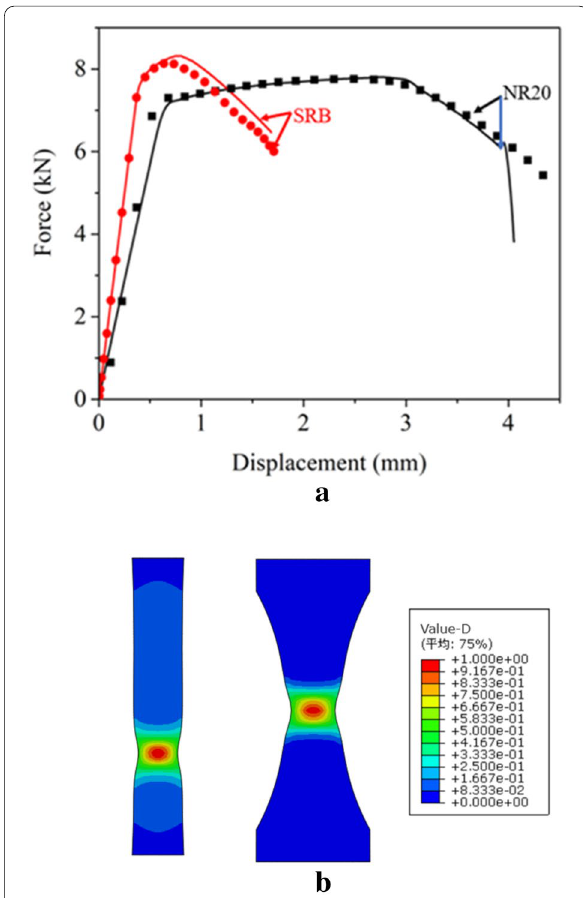
Figure 18 Application of the BW model: a experimental and computational force–displacement responses and b field of damage